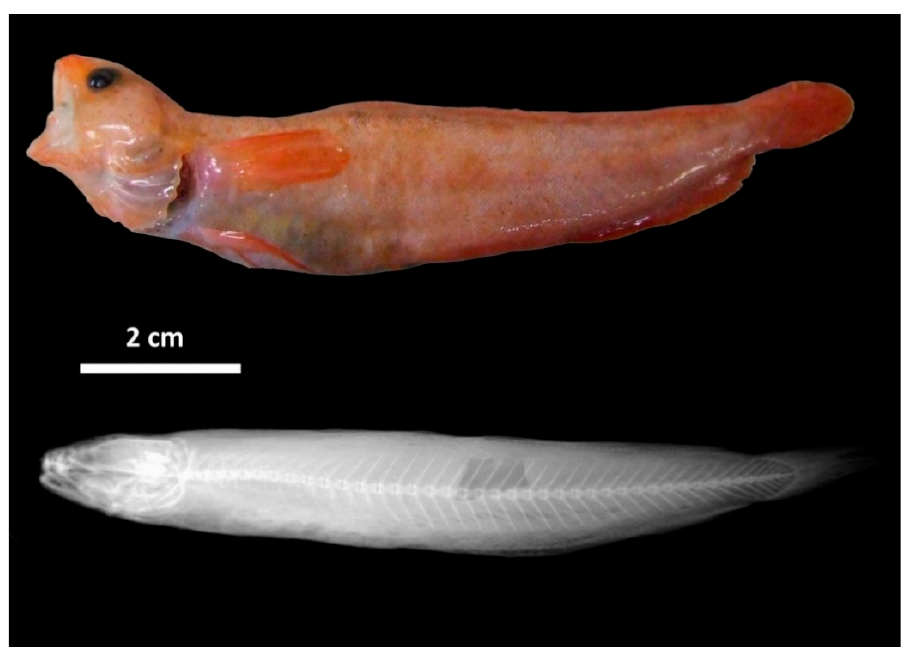
Figure 2. Gaidropsarus gallaeciae sp. nov., holotype (MHNUSC 10126-1) 98.5 mm SL ( top ), X-ray of entire body ( down ).